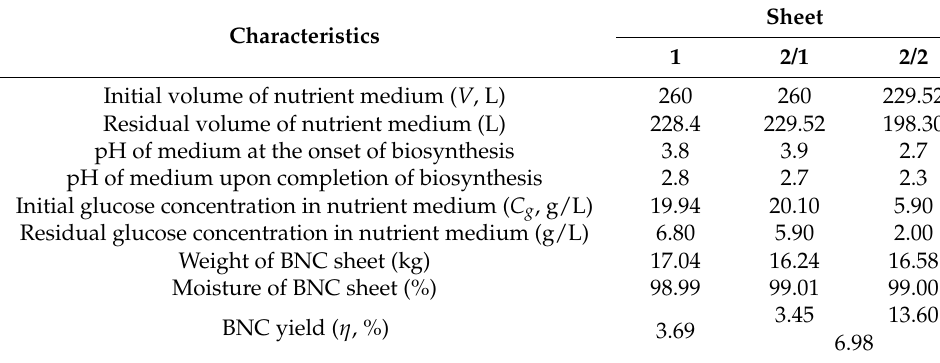
Table 1. Basic indicators of BNC